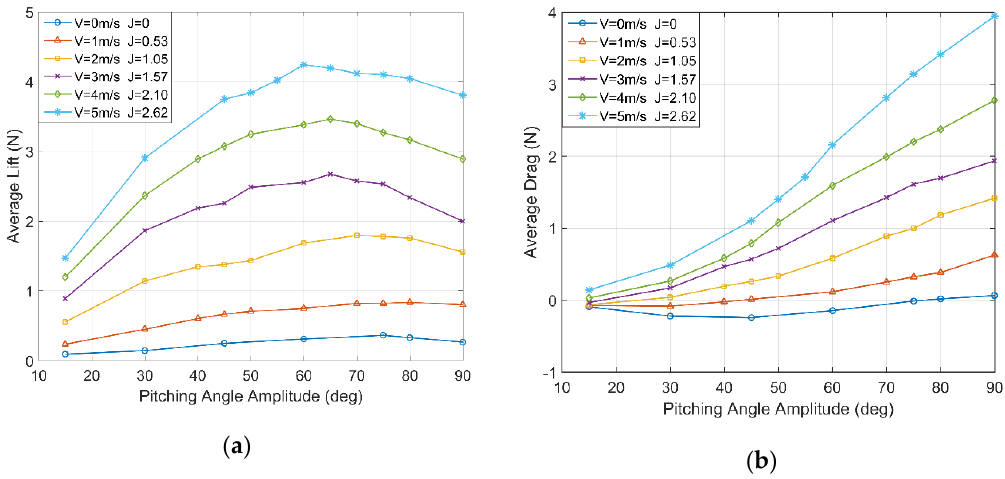
Figure 21. Average lift ( a ) and drag ( b ) of different amplitudes under different flows. The average lift and drag forces increase with the velocity above zero for any pitching